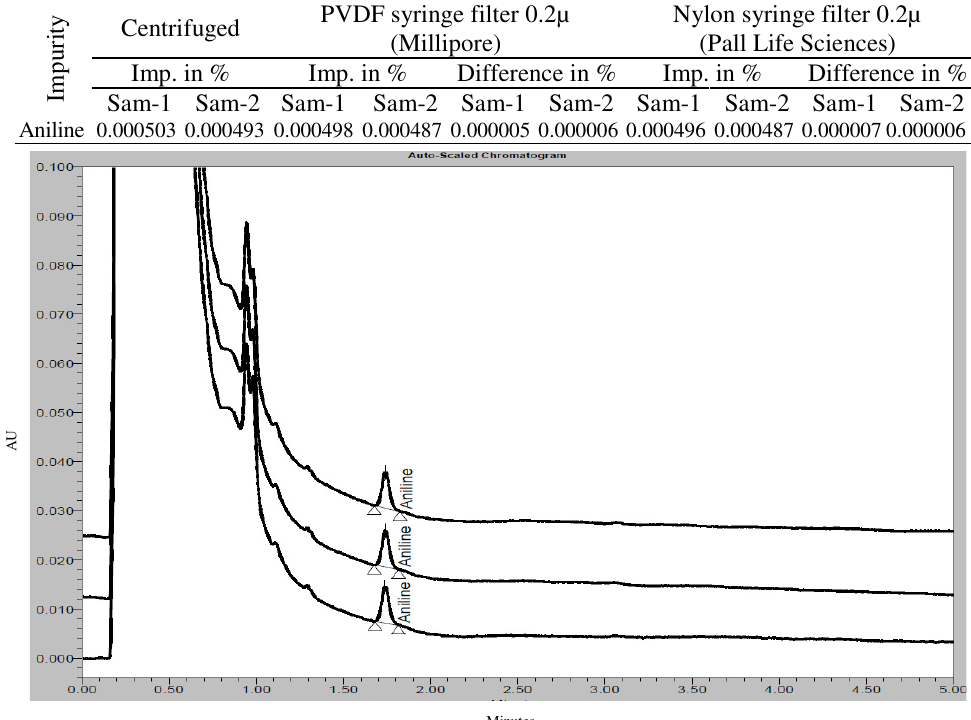
Table 8. Filter compatibility